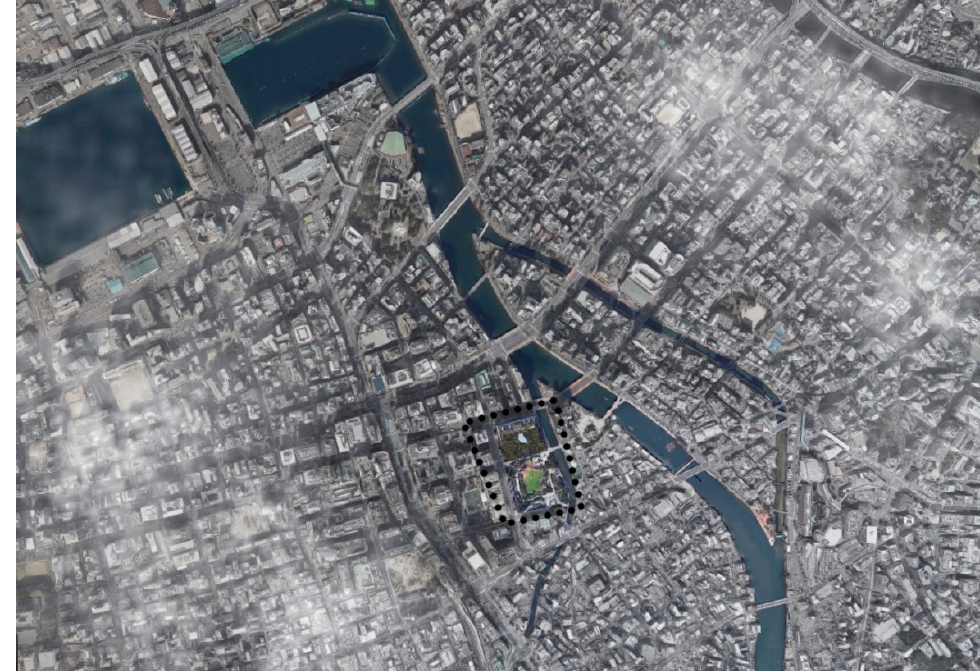
Figure 1. Location of the Prefectural International Hall “Asian Cross Road Over the Sea” in the city of Fukuoka, Japan; graphic processing, based on Google Maps, by E. Latusek.